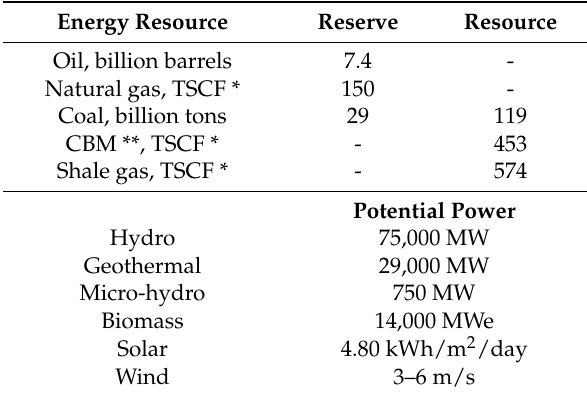
Table 1. Indonesia’s energy resources [7].